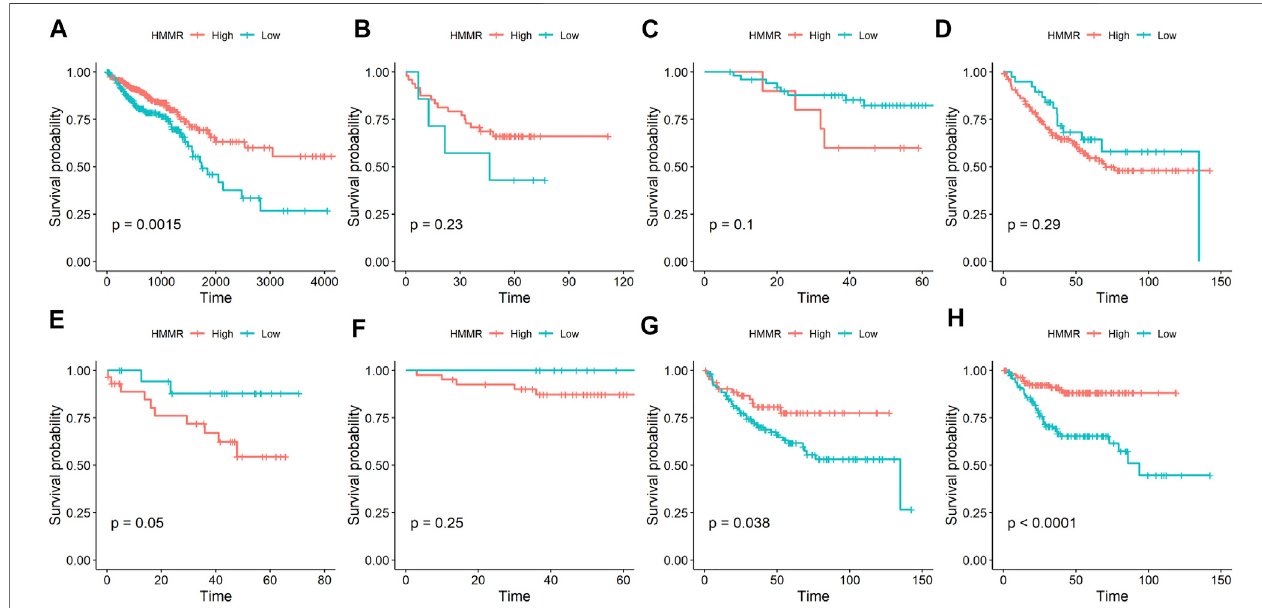
FIGURE 4 | Association of the expression of HMMR with survival in patients with CRC. (A) OS results in TCGA-COAD and -READ datasets; (B) OS results in the GSE17537 dataset; (C) OS results in the GSE12945 dataset; (D) OS results in the GSE17536 dataset; (E) DFS results in the GSE17537 dataset; (F) DFS results in the GSE12945 dataset; (G) DFS results in the GSE17536 dataset; (H) DFS results in the GSE14333 dataset. OS: overall survival; DFS: disease-free survival.